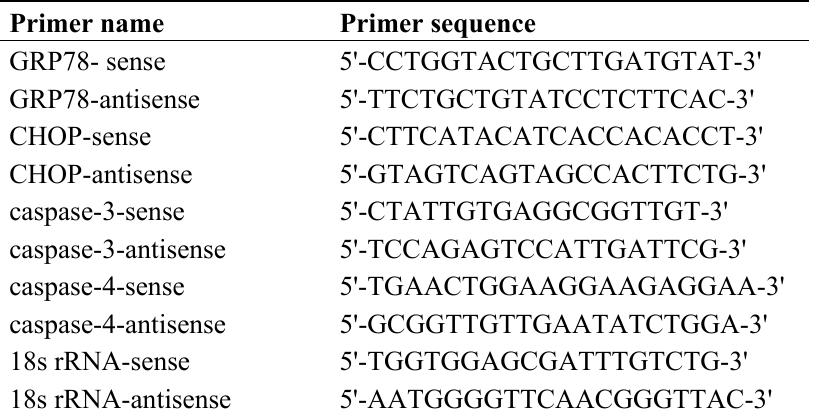
Table 1. Sequences of primers used for real-time